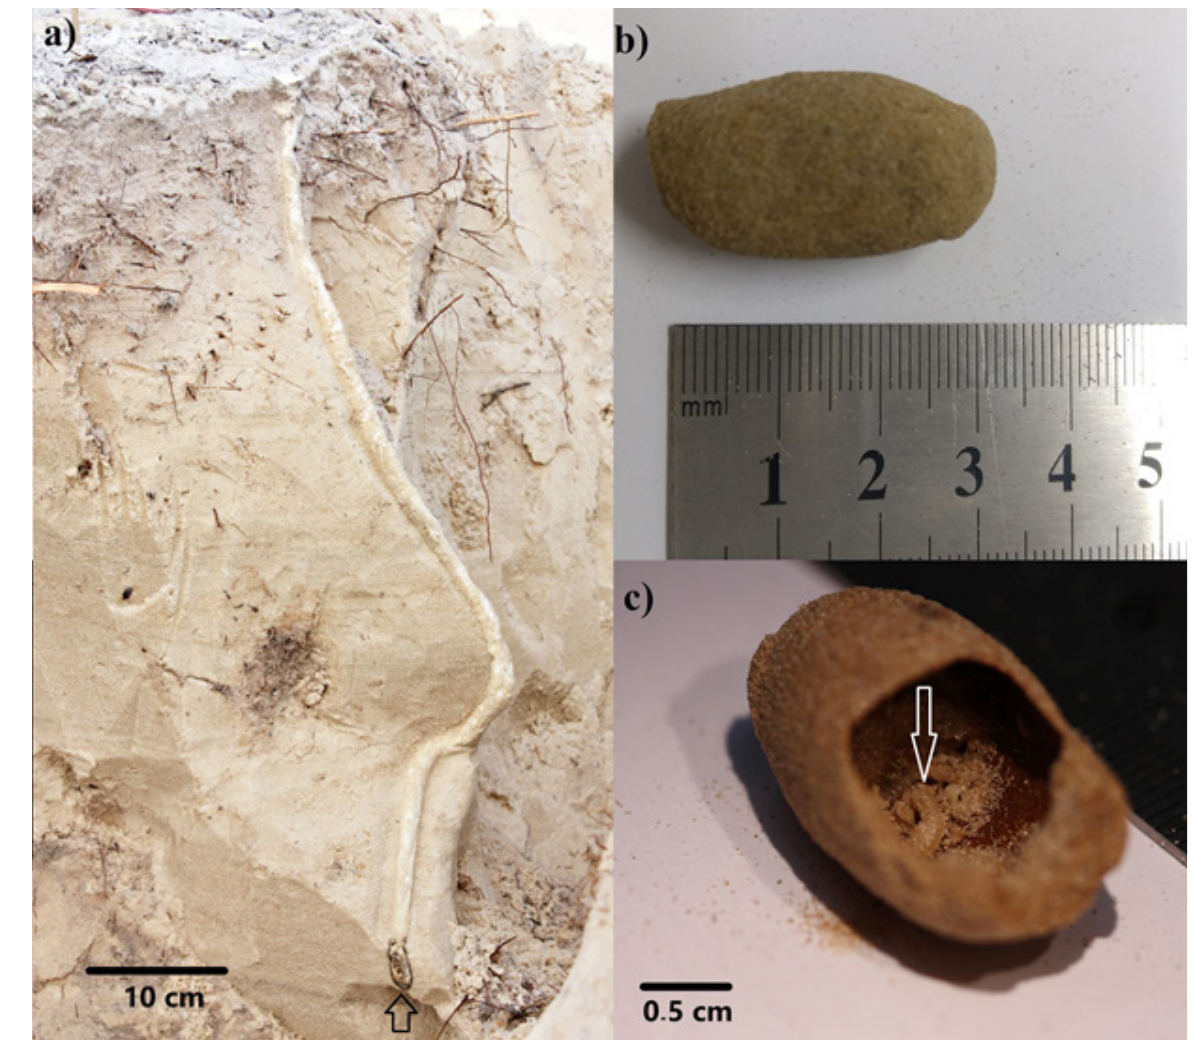
Fig 3. (a) Detail of an excavated nest, showing the main tunnel and the cell (arrow) connected to it. (b) The outer view of the cell shown laterally. (c) Longitudinal view of an opened cell with larva inside it